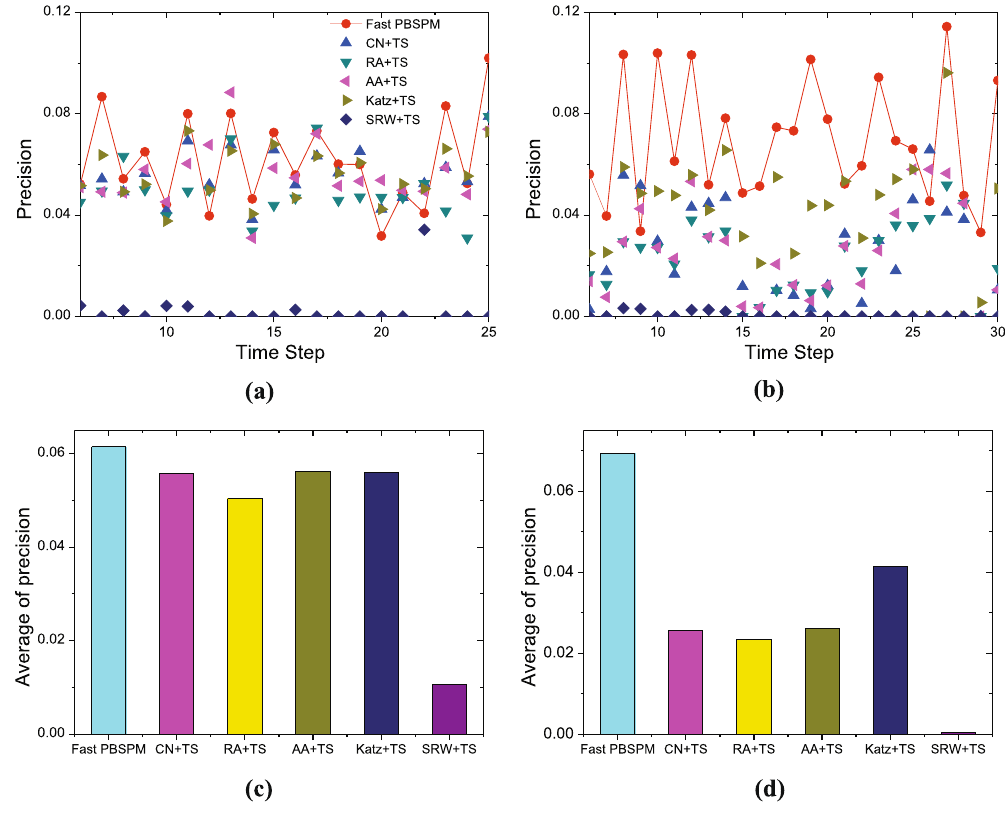
Figure 5. Precision at different time steps and their average values. G t~t + T − 1 ( G t , G t + 1 , … , G t + T − 1 ) and G t + T play the role of the training set E T and probe set E P . Panel (a) and panel (b) show the precision values at different time steps for LKMLR and Wiki. The red curves are respectively obtained by the fast PBSPM with α = 2 and 5, m = 2 and 2. The other results are obtained under optimal cases by different forecasting models. Panel (c) and panel (d) give the average precision values of different methods for the two